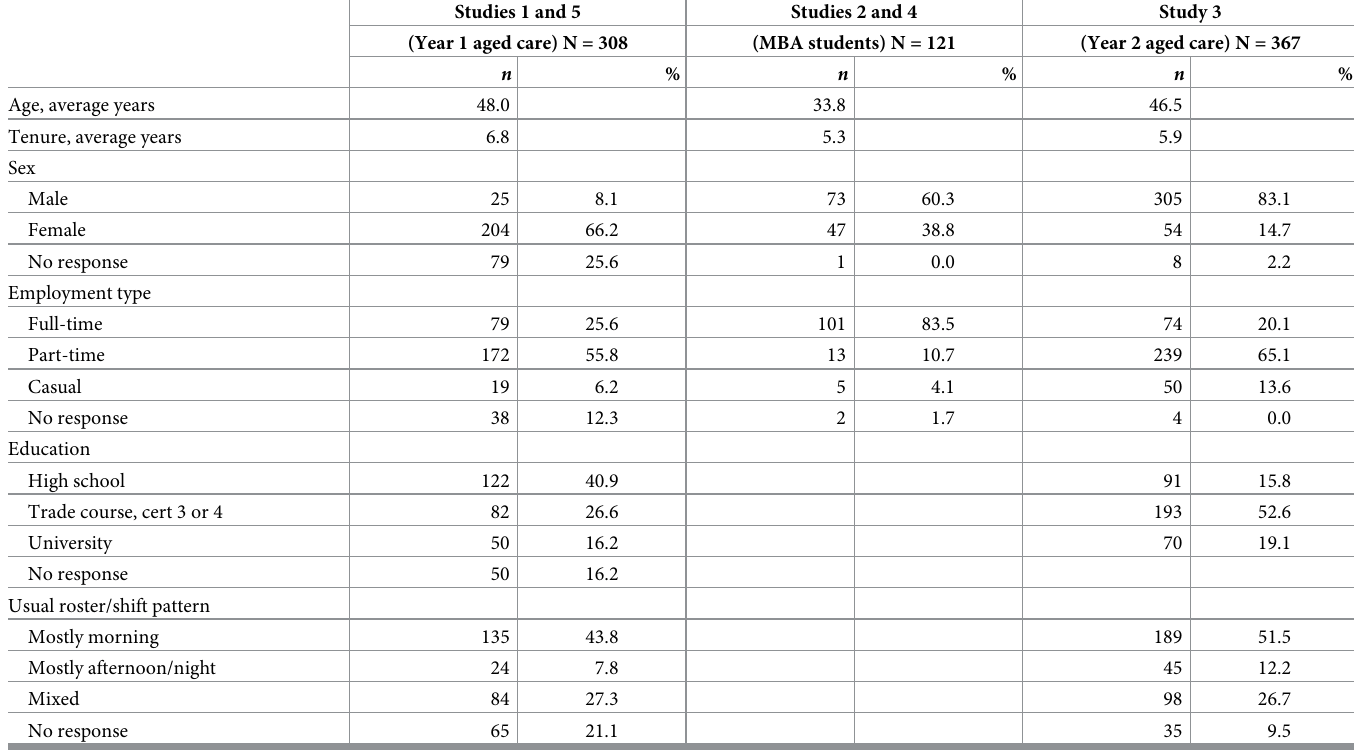
Table 1. Demographics of respondents (all